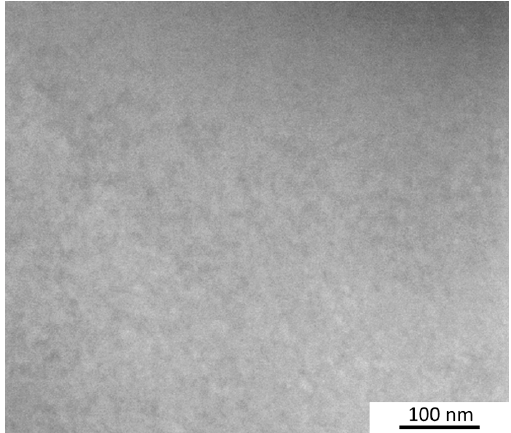
Figure 9. HAADF STEM image of the sample aged at 500 °C for 1500 s, showing homogenization of spinodal domains.